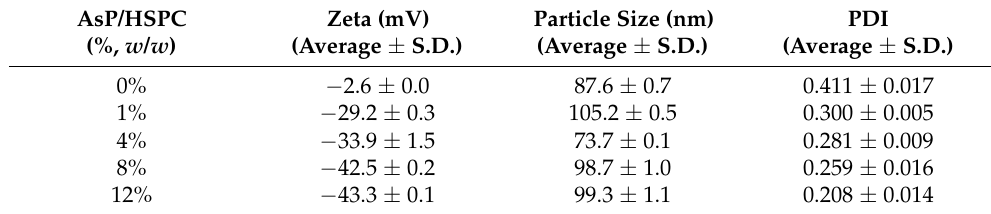
Table 1. Effect of AsP/HSPC ratios on zeta potential and particle size of AsP-PC-LNPs ( n = 3).